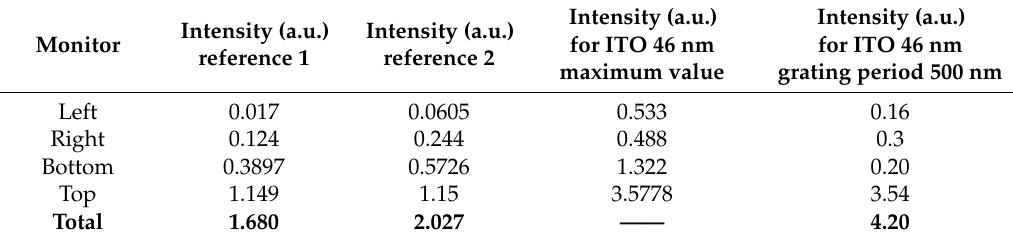
Figure 5. Light extracted from LED as the grating period is varied. ( a ) Light extraction from four monitors (top, bottom, left side, and right side) compared with conventional LED (reference 2) for an ITO thickness of 46 nm; ( b ) total light extraction for difference ITO thicknesses and compared with reference 1 with an ITO of 46 nm and reference 2. Table 3. Light output intensities at difference monitors for ITO 46nm case and